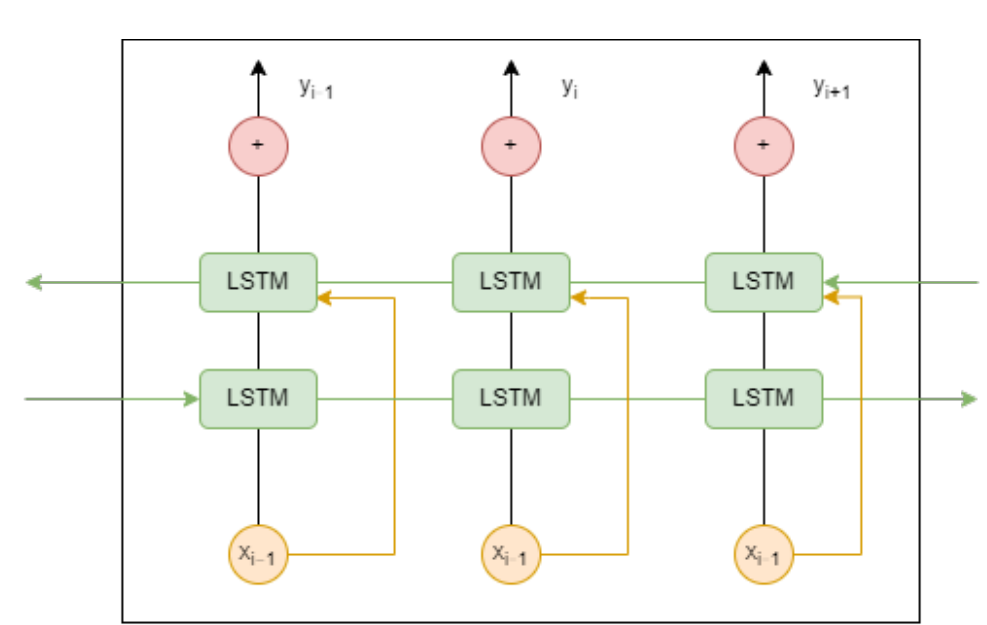
Figure 6. Overview of the Bi-LSTM architecture [55] illustrating the flow of input (x), output (y), and LSTM